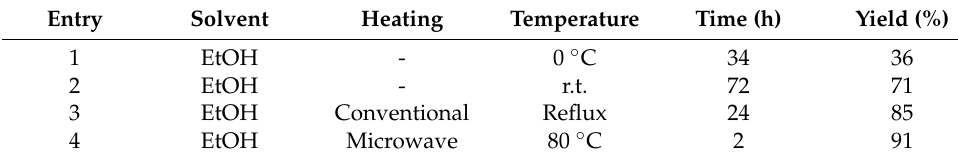
Table 2. Results of the evaluation of temperature and heating mode for the synthesis of 1a .